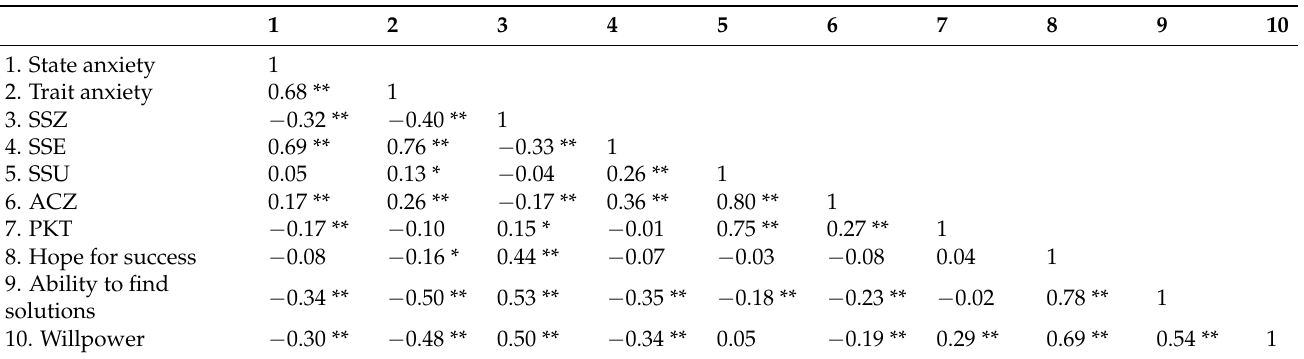
Table 4. Pearson’s correlations between anxiety, coping styles, and hope for